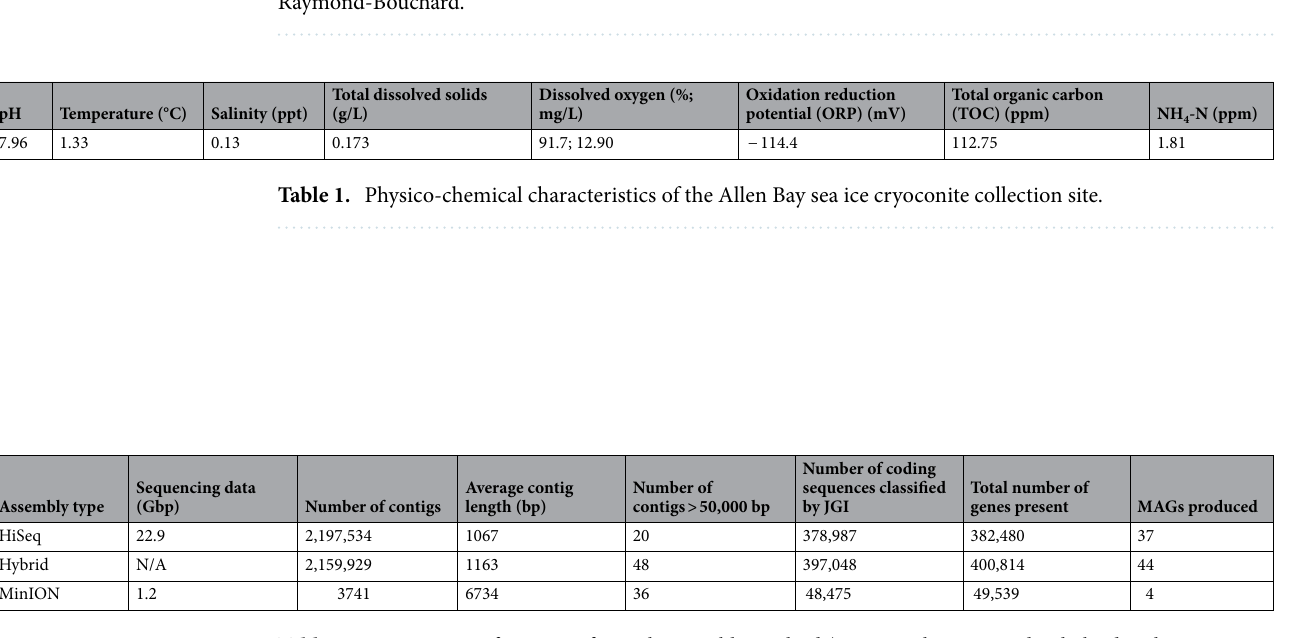
Table 2. Sequencing information for each assembly method (HiSeq with metaSPAdes, hybrid with metaSPAdes and combined HiSeq/MinION datasets, MinION with